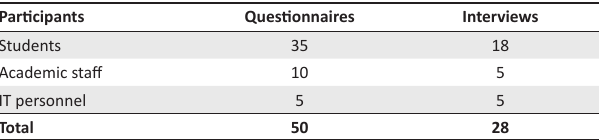
TABLE 1: Research